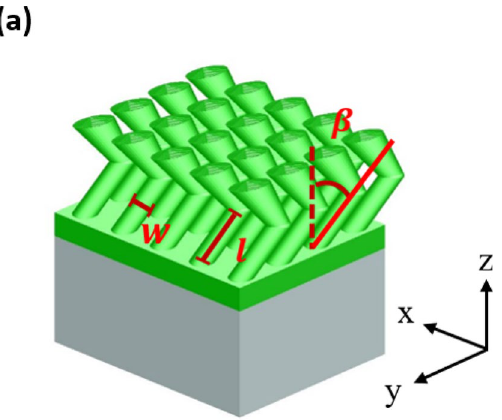
Figure 7. A truncated view of the two-layered TiN NRA on a 39 nm-thick uniform TiN film for simulation. The substrate is a BK7